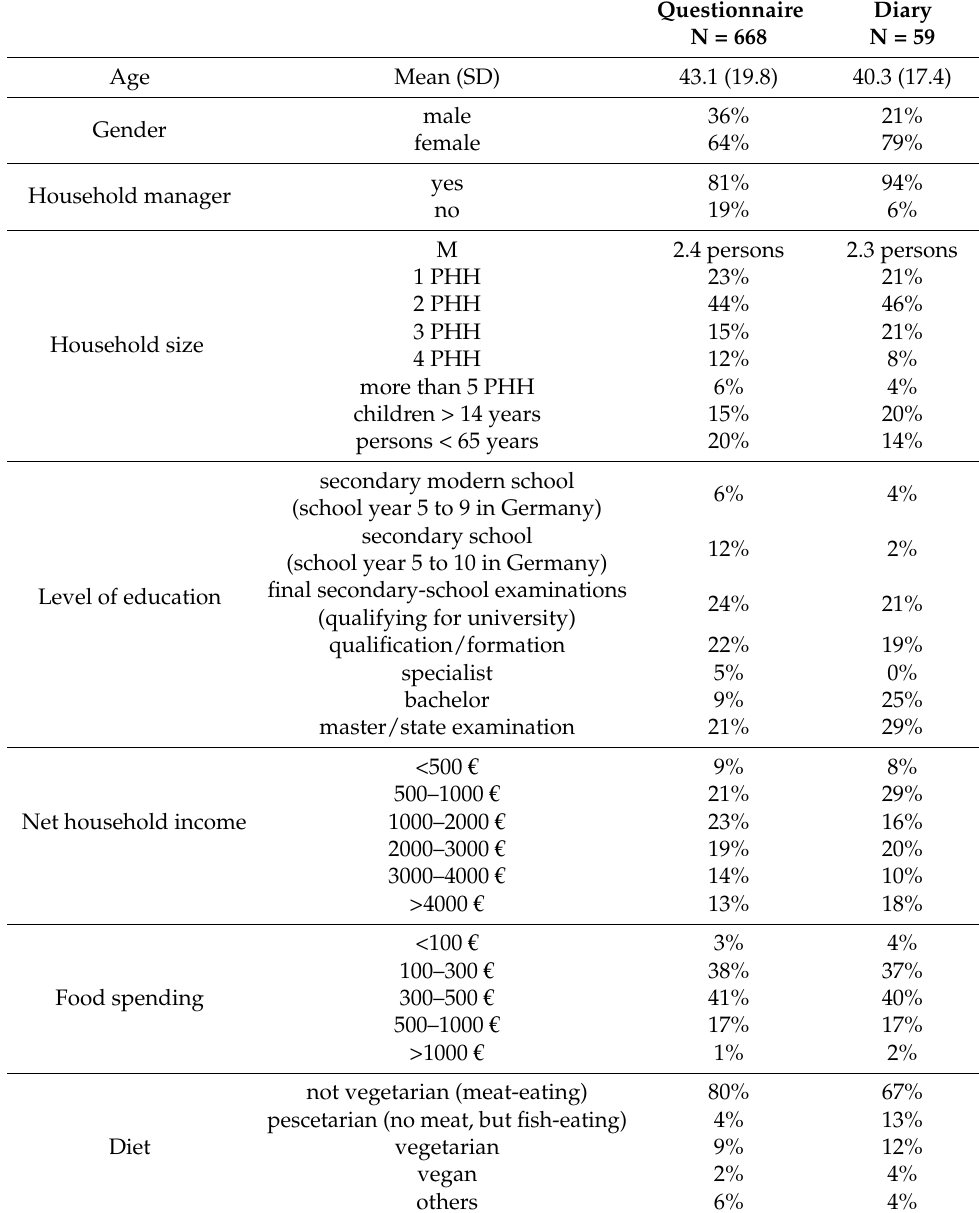
Table 4. Descriptive